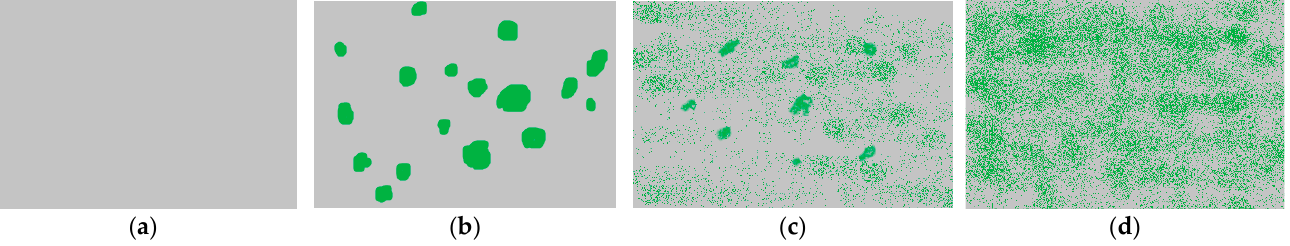
Table 2. The size of NR conglomerates in the LDPE matrix depends on NR.